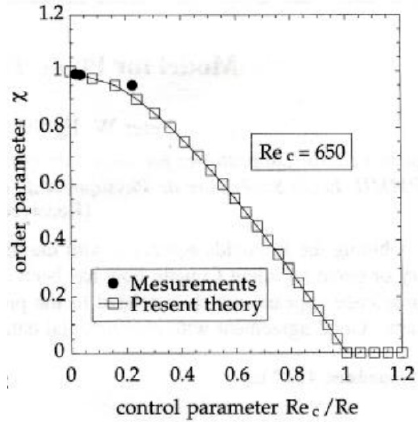
Figure 6. Order parameter χ , determined by Equation (13) and compared with experimental results from Reference [32]. There is a lack of good experimental results at excitations just slightly above the criticality Re c . This is explained by the inverse relation between α and Re and the difficulty for experimentalists to perform good experimental set-ups and experiments to measure the turbulent fields at values just slightly above the critical Reynolds number (for more details see in Reference [28]). Reprinted with permission by Egolf and Weiss (1995a) © 2021, American Physical Society.